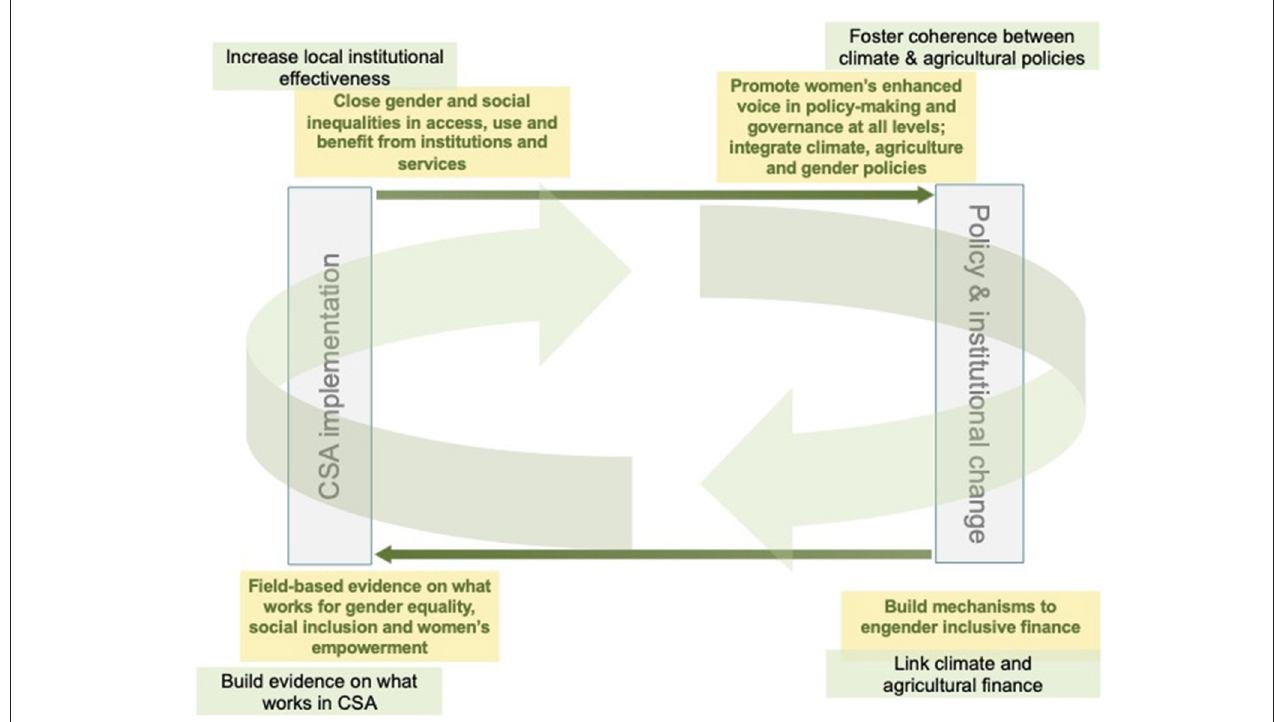
FIGURE 1 | Integrating gender and social inclusion into climate-resilient